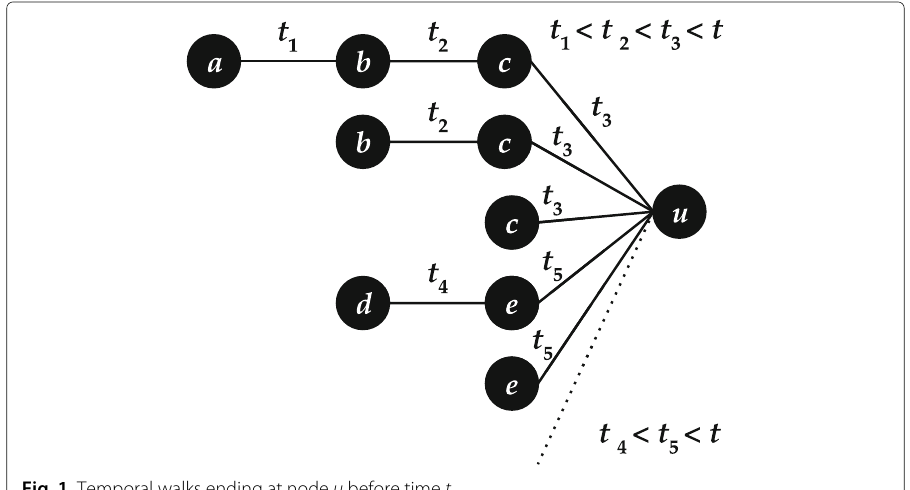
Fig. 1 Temporal walks ending at node u before time